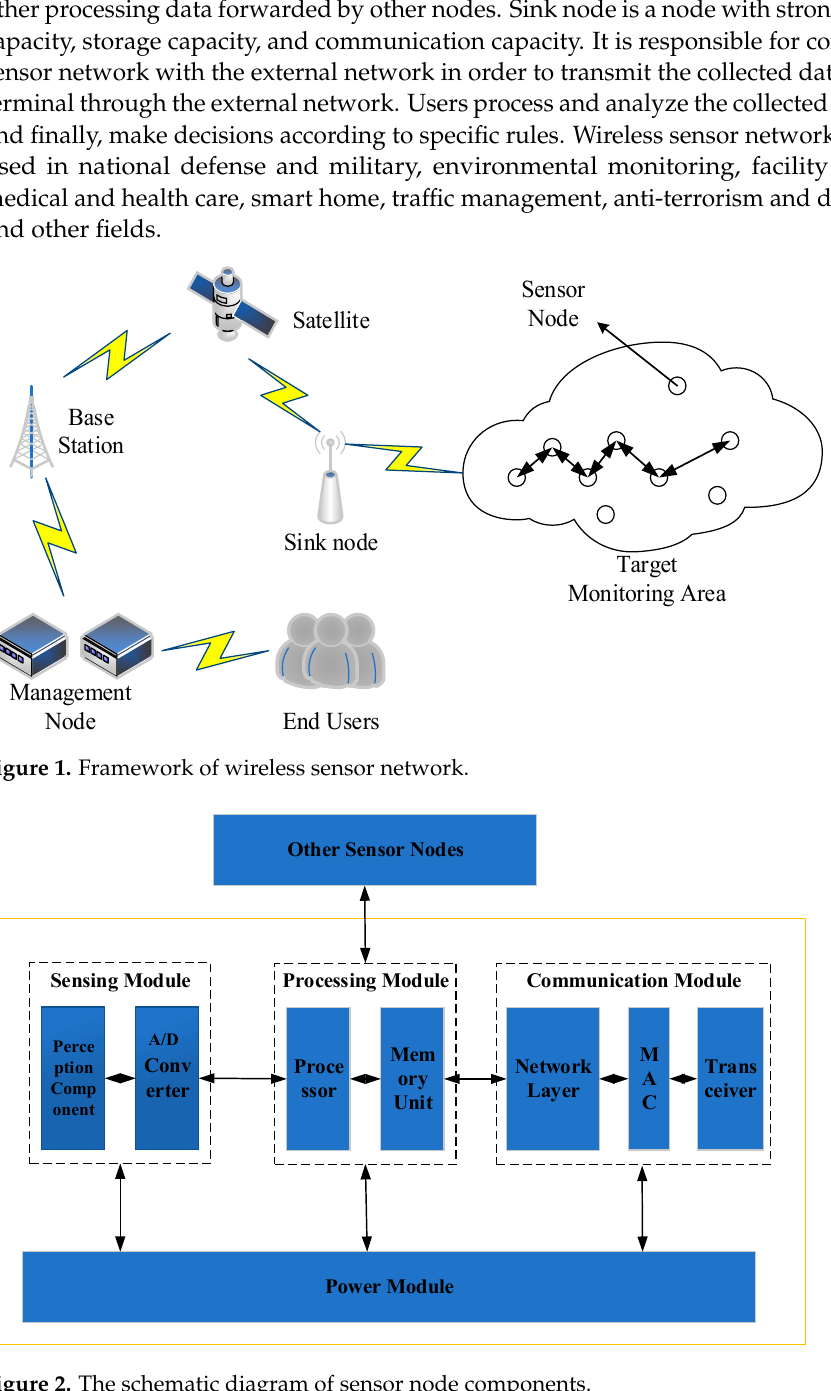
Figure 2. The schematic diagram of sensor node